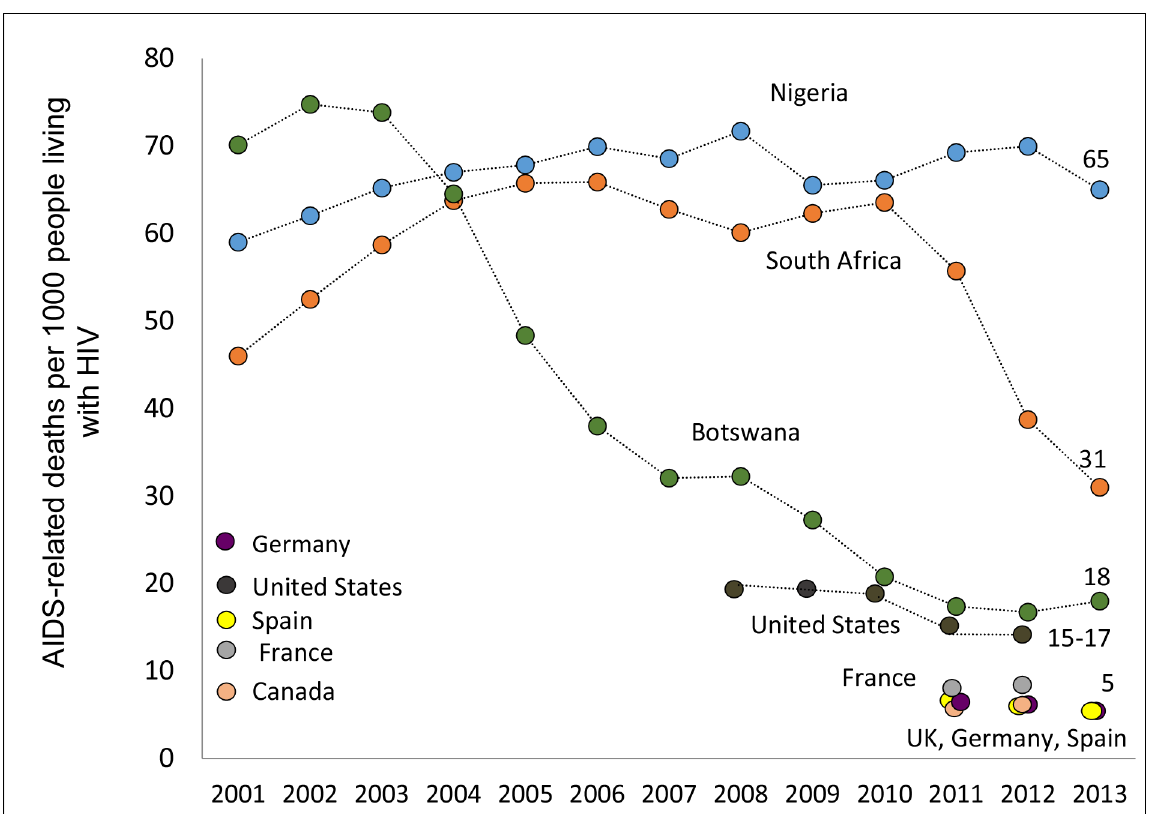
Fig 3. Trends in estimated death rate per 1000 people living with HIV, 2001 – 2013. Comparison of trends of estimated AIDS-related death rate per 1000 people living with HIV for selected high, middle and low-income countries from 2001 to 2013. Data from UNAIDS AIDSinfo data tool, 18 the 2012 and 2013 UNAIDS Global Reports 2 and Centers for Disease Control and Prevention Diagnoses of HIV Infection in the United States and Dependent Areas, 2011: HIV Surveillance Report, Volume 23.